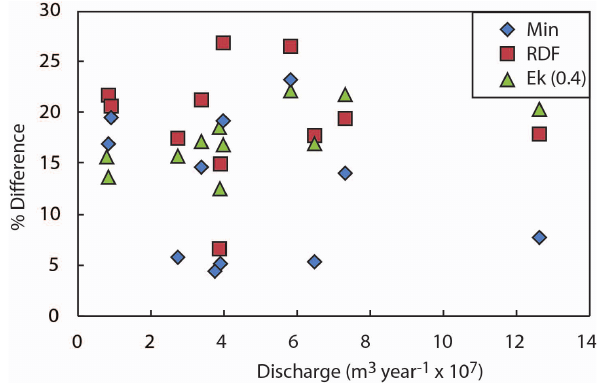
Fig. 10. Summary of the percentage difference of the estimated baseflow from the chemical mass balance technique and the local minimum (Min), the Lyne and Hollick digital filter (RDF) and the Eckhardt filter with BFI max =0.4 (Ek(0.4)). Data from Table